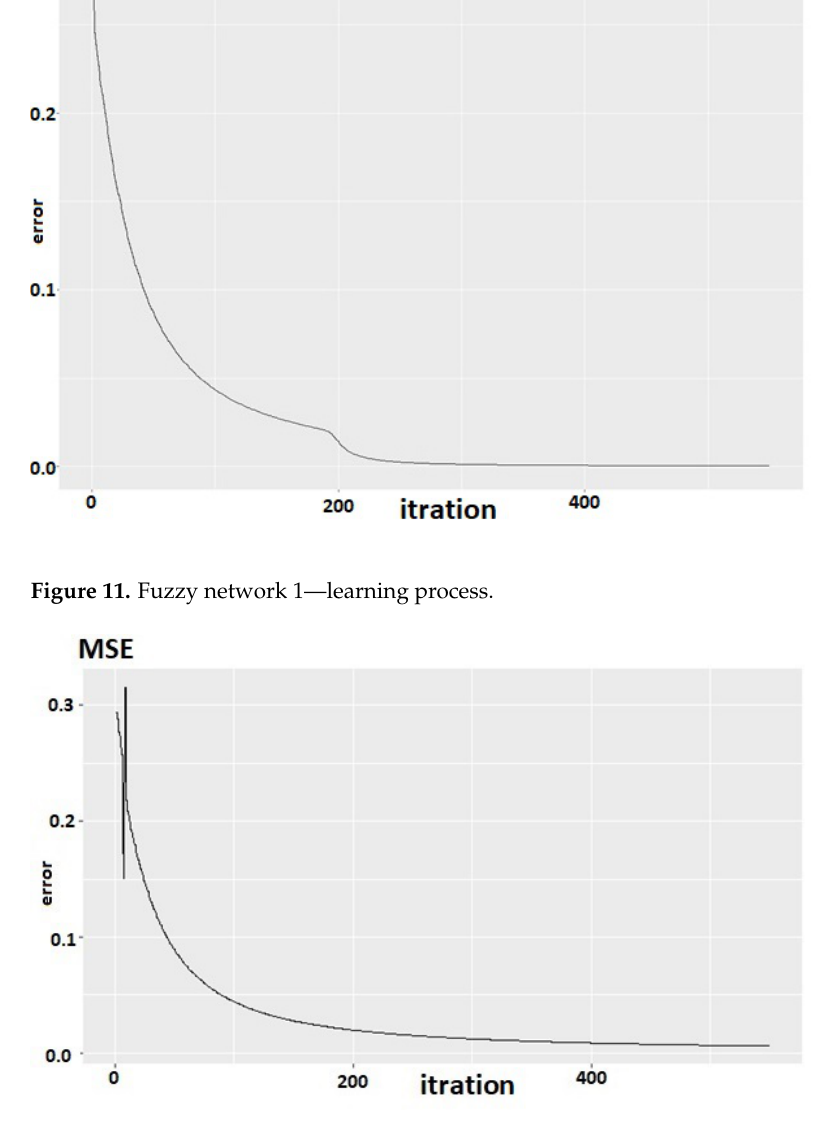
Figure 12. Fuzzy network 2—learning